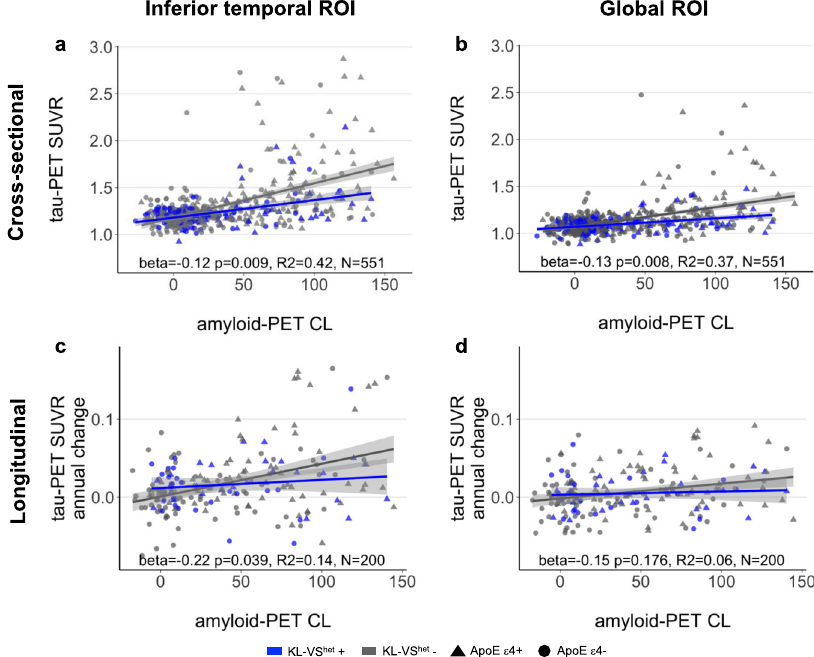
Fig. 1 Association between KL-VS heterozygosity, amyloid-, and tau-PET. Scatterplots display the relationship between global amyloid-PET levels and a , b cross-sectionally assessed tau-PET levels or c , d longitudinally assessed tau-PET annual change rates measured in inferior temporal gyri (left panel) and globally in neocortical areas (right panel) as a function of KL-VS het variant. Blue and gray colors indicate individuals with heterozygous or non- heterozygous KL-VS alleles. Statistics of the KL-VS het × amyloid-PET interaction effect on tau-PET uptake were derived from multiple linear regression analyses, controlled for the main effects of KL-VS het and amyloid-PET levels as well as age, sex, diagnosis, education, and ApoE ε 4 carrier status. Linear model fi ts are indicated together with 95% con fi dence